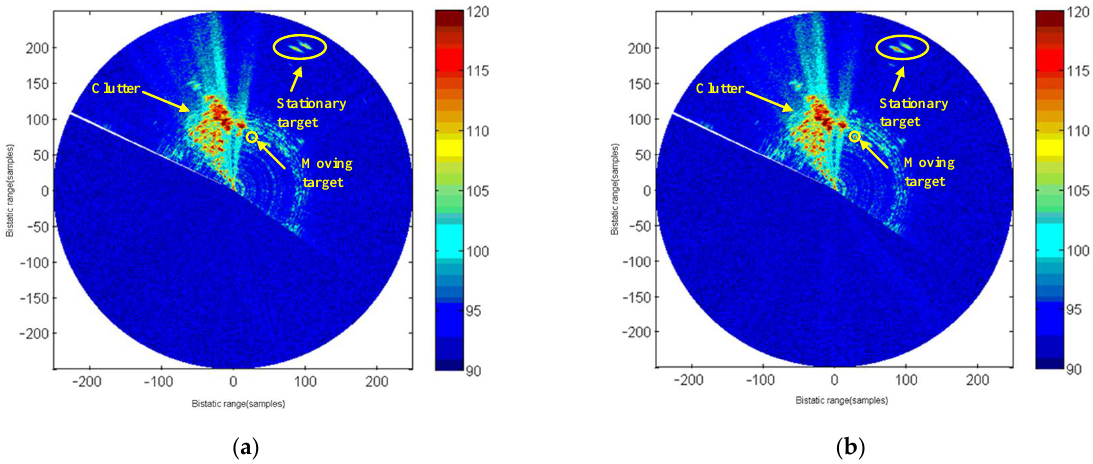
Figure 23. HBRmap for maritime moving target detection: ( a ) First circle; ( b ) Second circle.